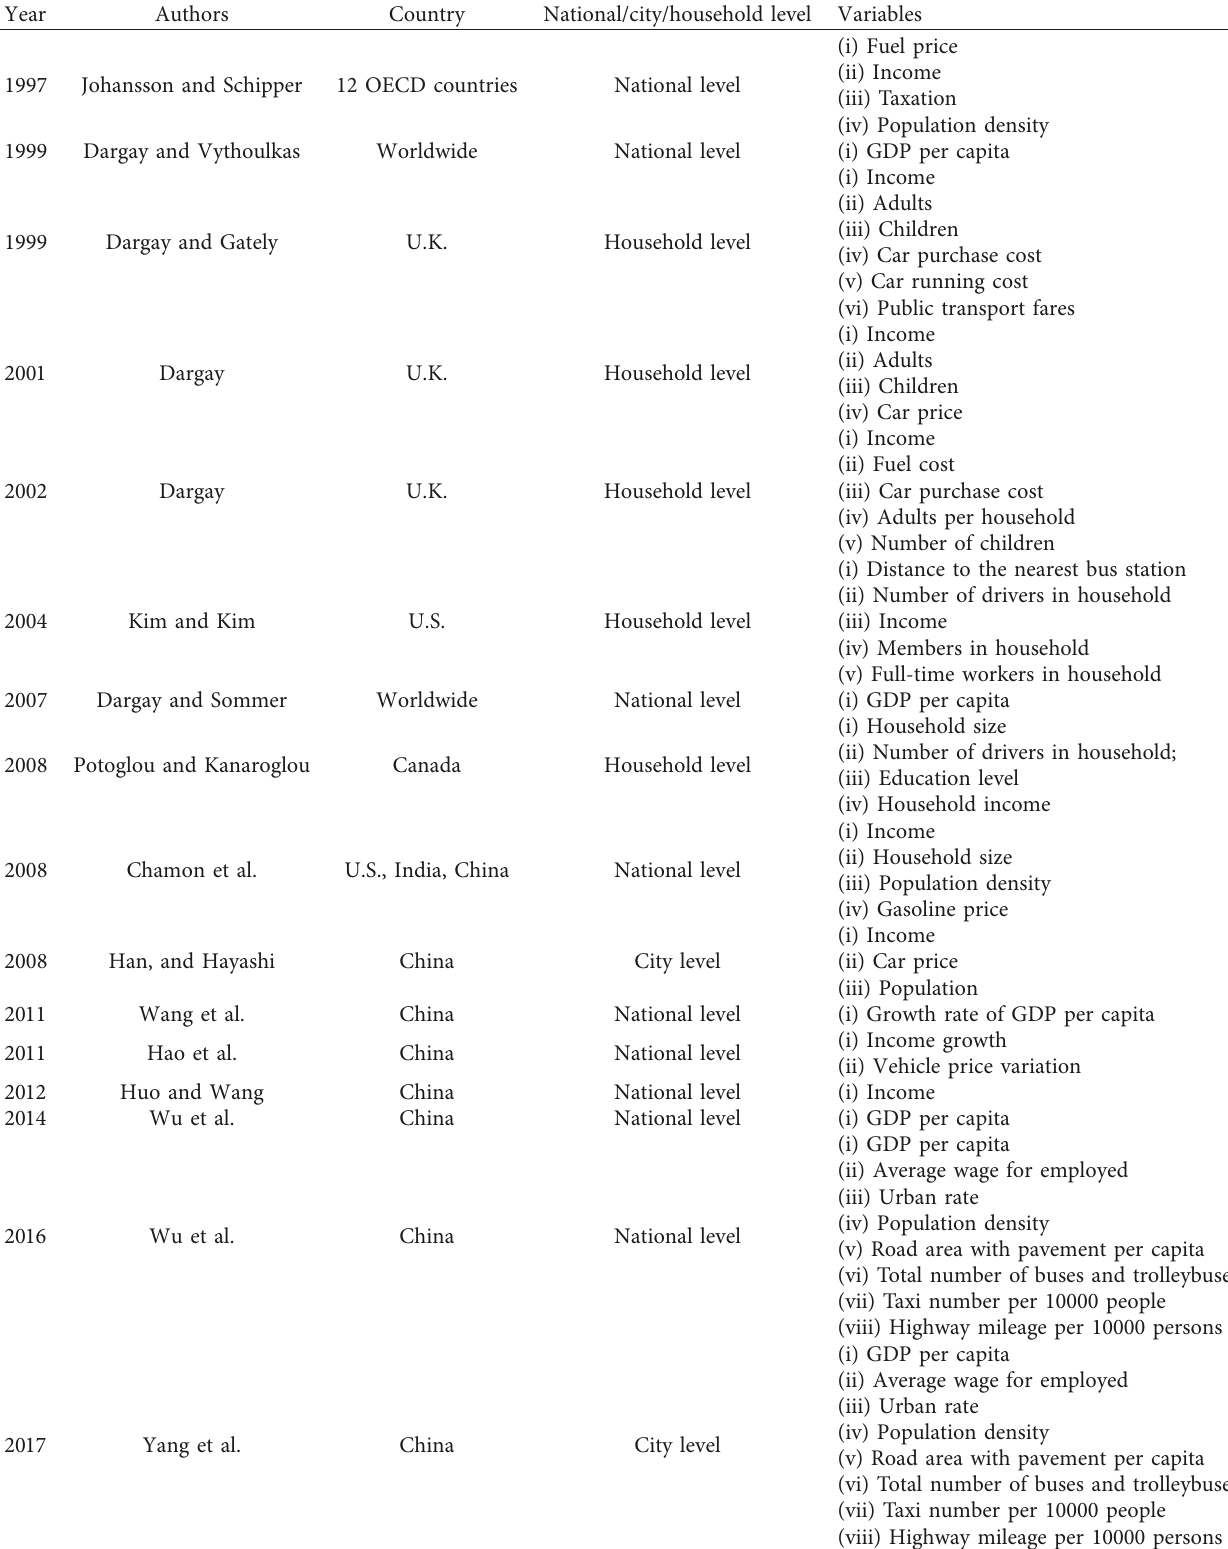
Table 1: Previous researches about vehicle